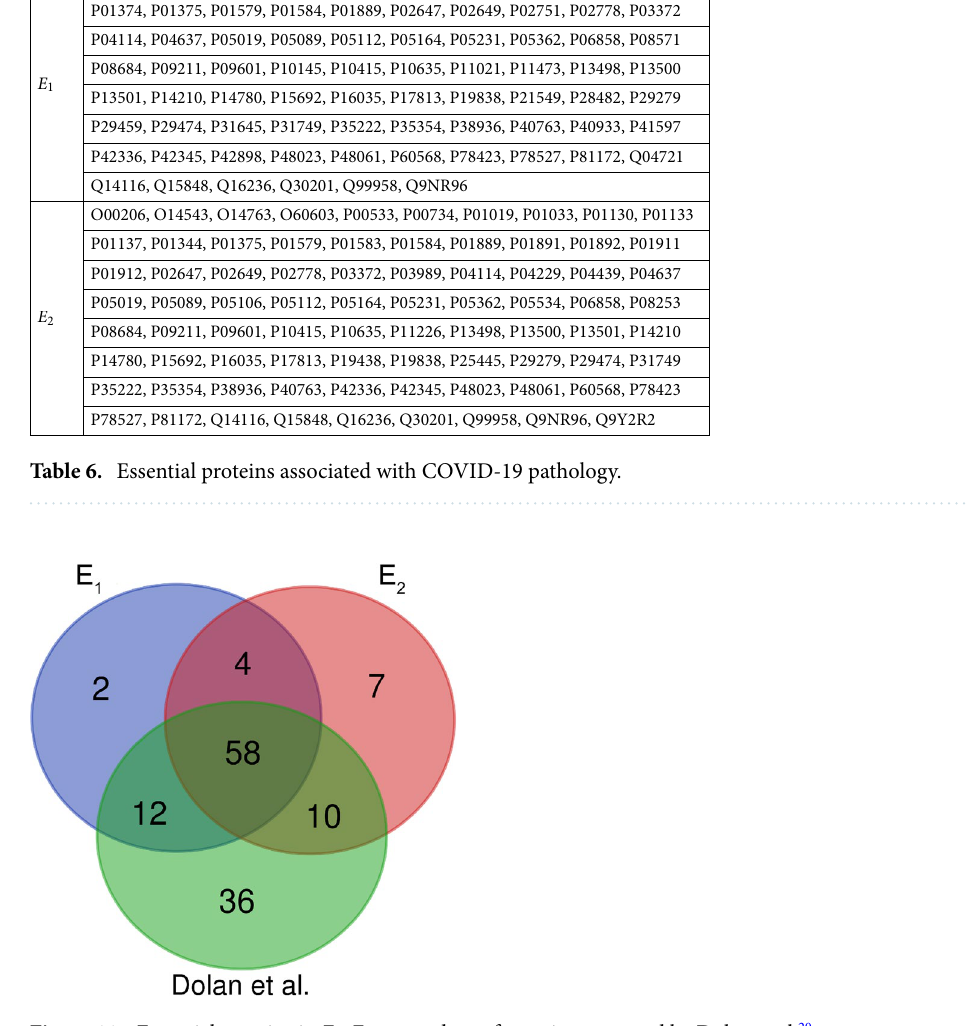
Figure 11. Essential proteins in E 1 , E 2 sets and set of proteins proposed by Dolan et al. 20